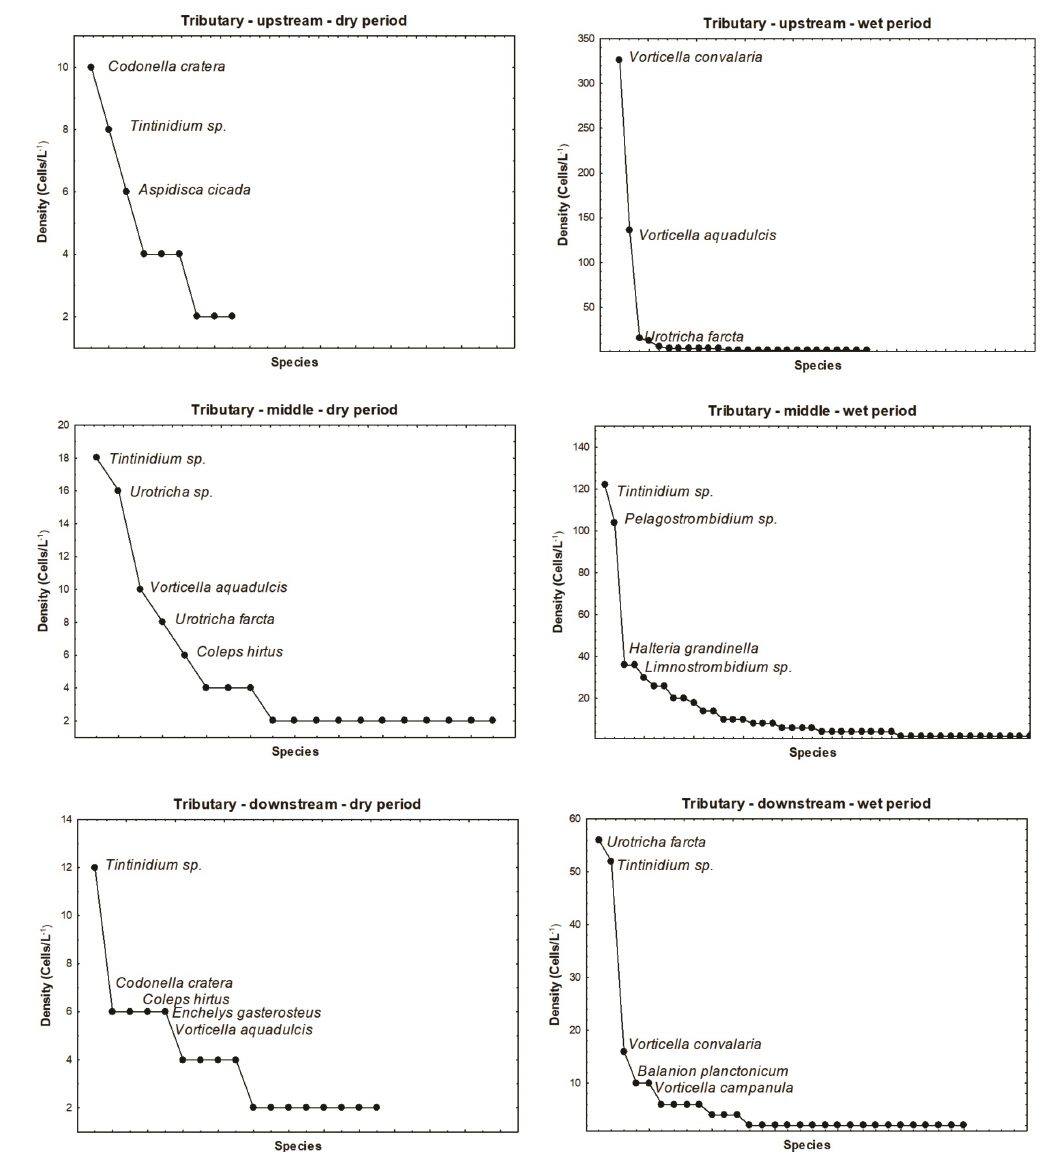
Figure 5. Plots of ciliates species abundance distribution in the tributaries of Paraná River during dry and wet periods.